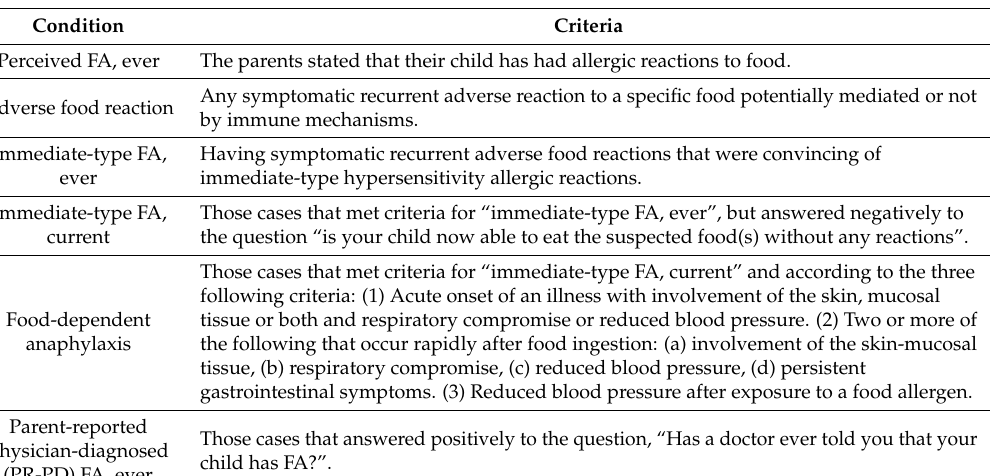
Table 1. Definitions utilized in this study.